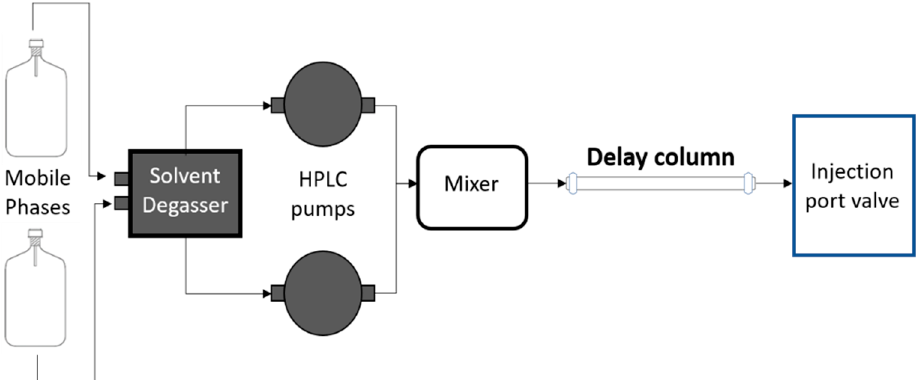
Figure 5. Column configuration.